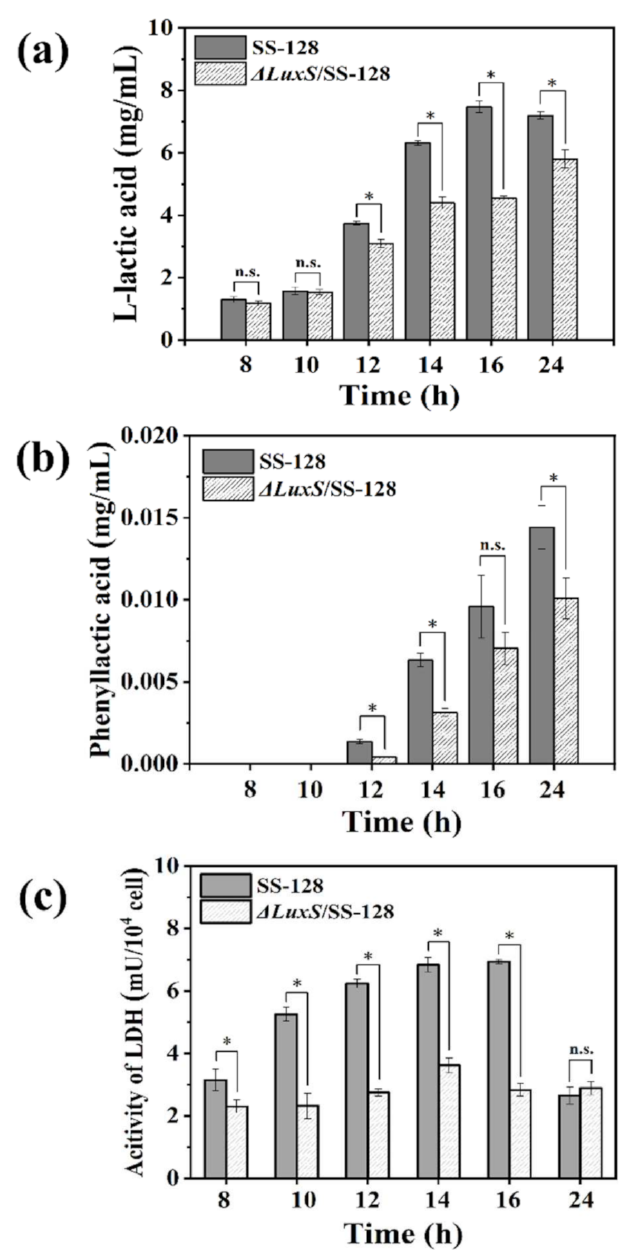
Figure 3. Extracellular concentrations of L-lactic acid ( a ) and PLA ( b ) detected by HPLC in SS-128 and ∆ luxS /SS-128; LDH activity ( c ). All data points mean ± standard deviations ( n = 3) with * denoting statistically significant differences ( p < 0.05); n.s.: not